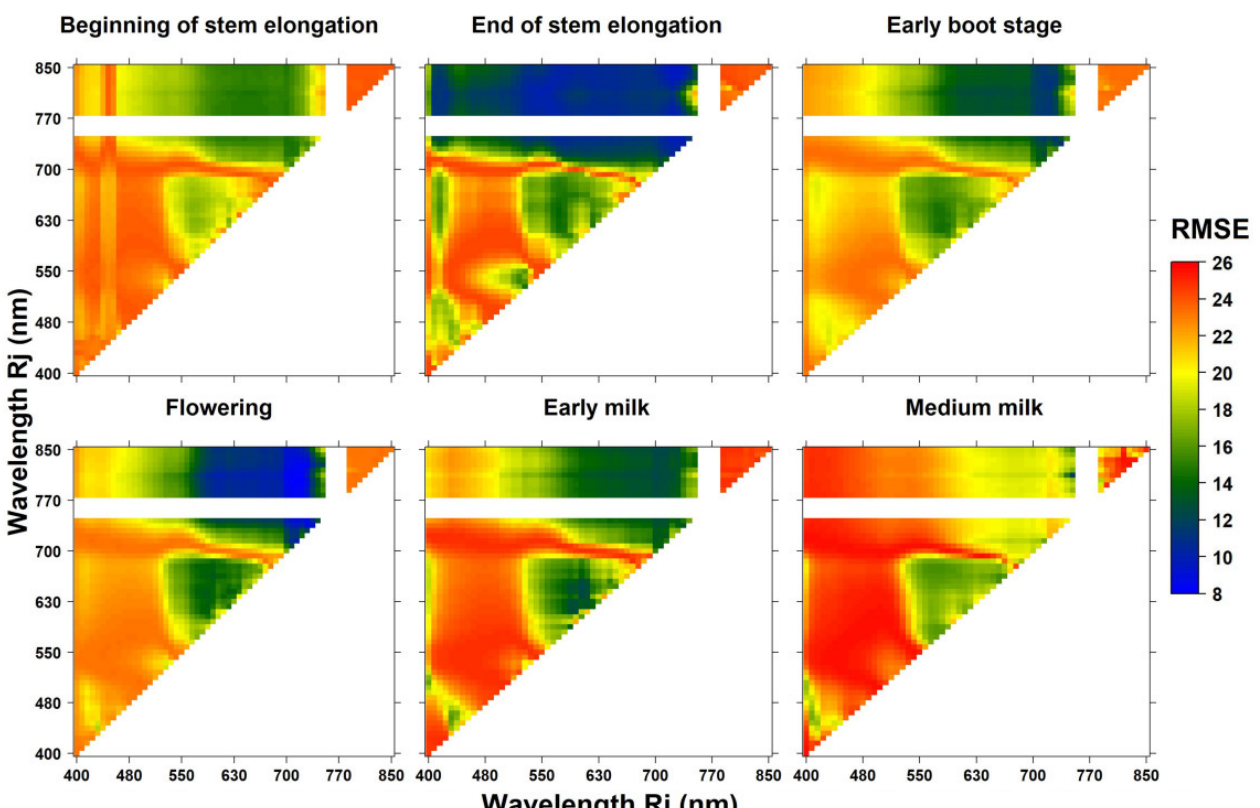
Figure 8. Contour maps of the root mean square error (RMSE, kg ha − 1 ) between the NDSI ( Ri , Rj ) and N output using the